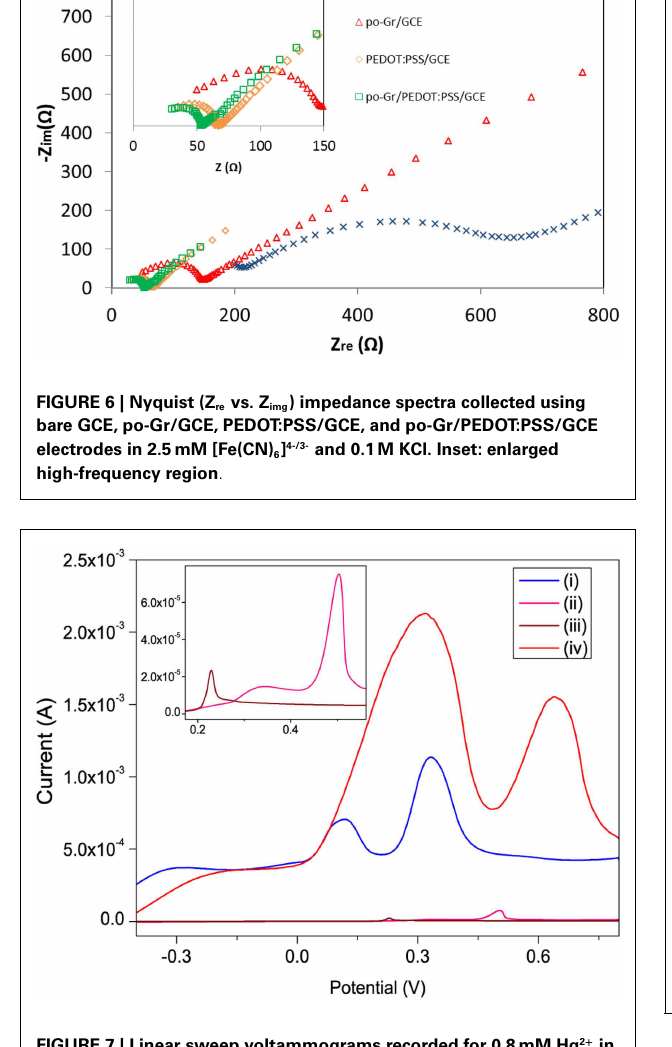
FIGURE 7 | Linear sweep voltammograms recorded for 0.8mM Hg 2 + in 0.05M HNO 3 solution on (i) PEDOT:PSS-, (ii) po-Gr-, (iii) bare-, and (iv) po-Gr/PEDOT:PSS/modified GCE’s. Inset: enlarged bare and po-Gr-modified GCE’s . Scan rate = 100mV/s.